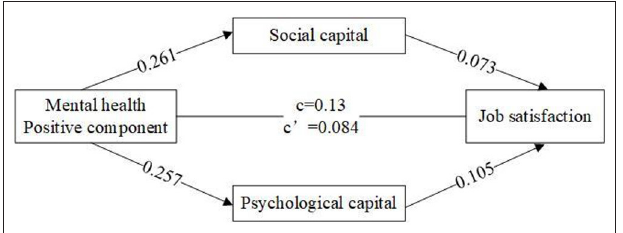
FIGURE 2 | The mediating role of psychological and social capital between the positive component of mental health and job